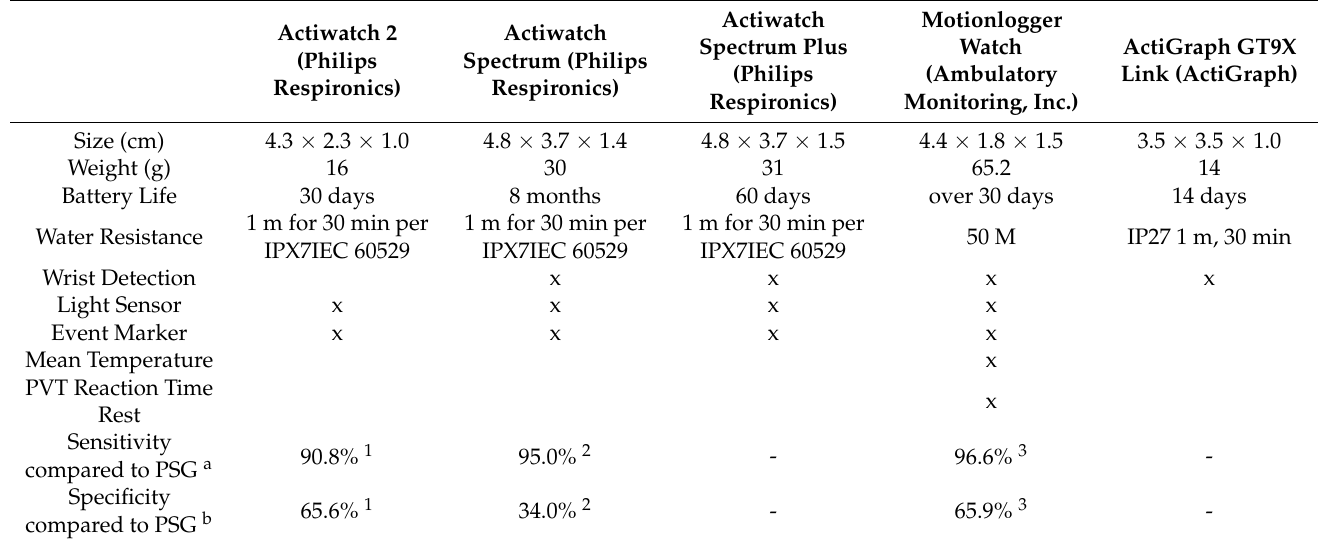
Table A1. Comparison of the available actigraphy devices used in the studies (as of December